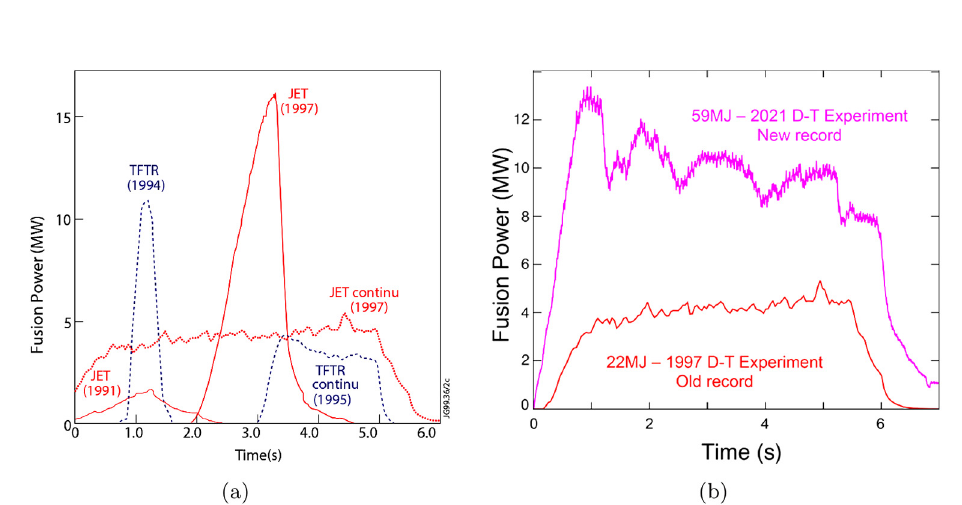
Fig. 12. – (a) Time traces of the fusion power released in different high performance deuterium- tritium fusion experiments in TFTR and JET in the 1990s. (b) Time traces of the D-T experi- ments with record fusion energy production in JET in December